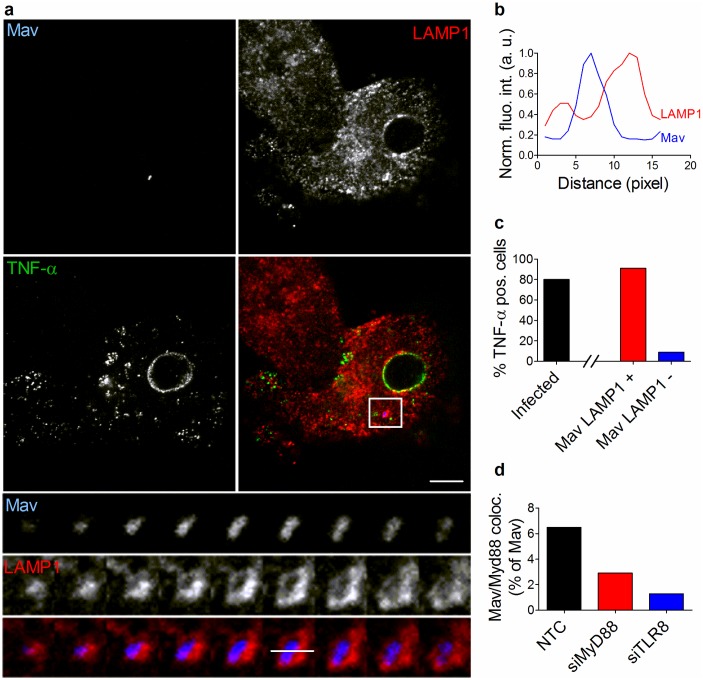
TNF production coincides with phagolysosomal localization of Mav.Human MDMs were infected with live Mav-CFP (blue) for 10 min, chased for 4h in the presence of a protein secretion inhibitor to accumulate cytokines, fixed and stained with antibodies to LAMP1 (red) and TNF (green). (A) Single and merged images of one cell; bottom-to-top projections of 3D-stack from boxed area in lower panels show that Mav is in a LAMP1+ compartment. (B) Fluorescence intensity profiles along the indicated lines of the Mav phagosome (Mav: blue trace; LAMP1: red trace). (C) Quantification of the percentage of infected cells secreting TNF (black bar), and of these, the fraction with Mav in LAMP1+ compartments (red bar) or LAMP1- compartments (blue bar). Quantification graphs represent the mean value +/- SEM from two different experiments. (D) Human MDMs were treated with siMyD88, siTLR8 or non-targeted control before infection with Mav for 10 min and chase for 4h. Cells were then stained with antibody to MyD88 and analyzed using confocal microscopy for recruitment of MyD88 to Mav phagosomes. Quantification graph represents MyD88-Mav association from two independent experiments. Scale bar represents 10 μm.